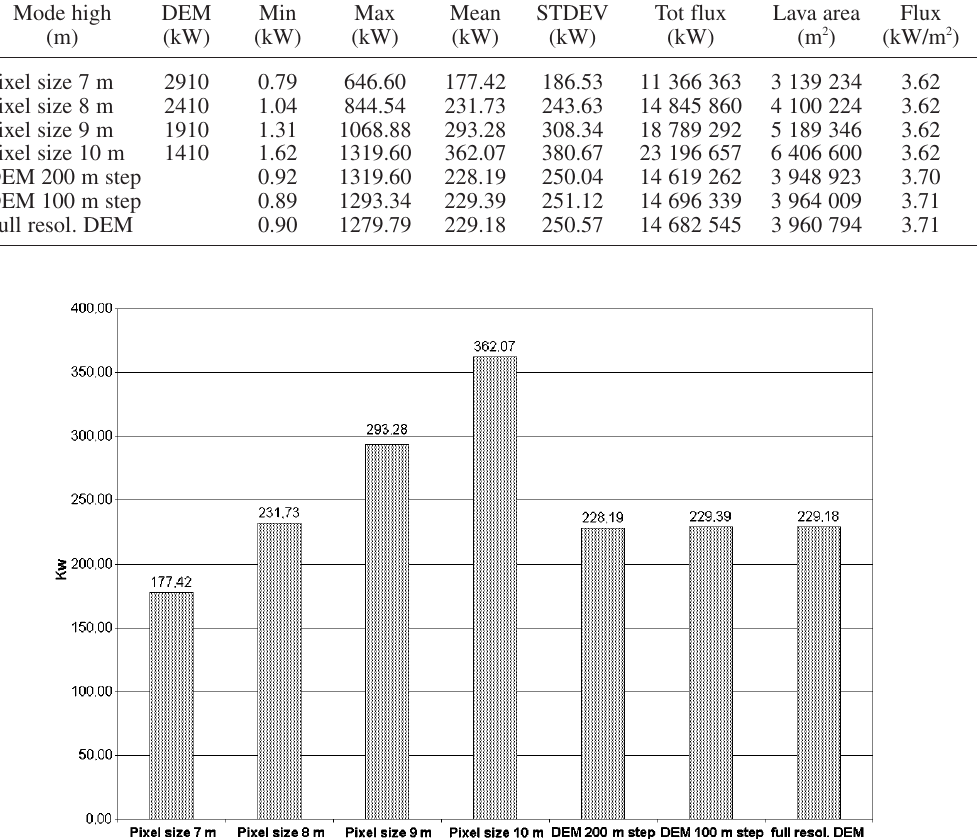
Fig. 7. Energy flux calculated on the entire image using constant values for the pixel-size (7, 8, 9, 10 m re- spectively) or values derived from a 10 m, 100 m and 200 m resolution DEM.